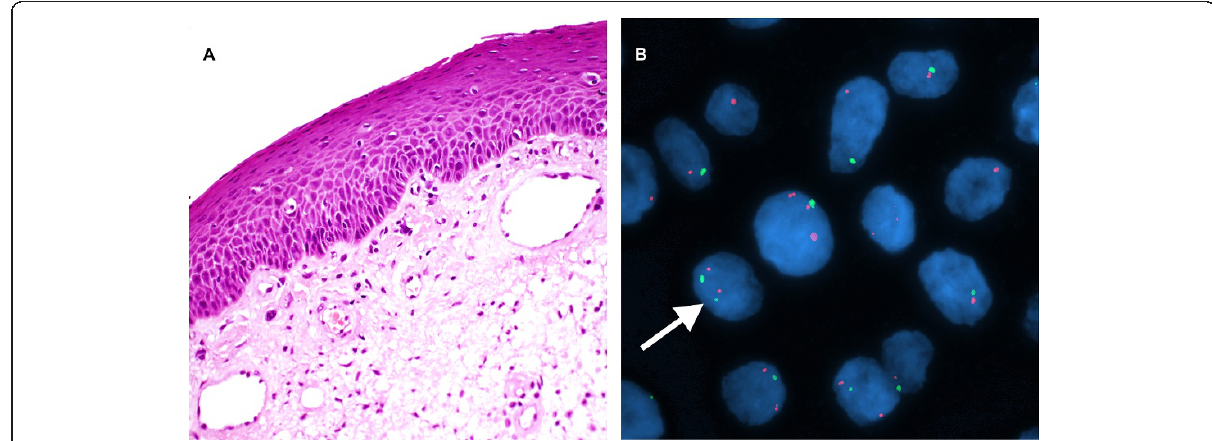
Figure 1 A case of normal epithelium of the larynx . A. H&E stain. (magnification, ×200). B. Interphase FISH displaying a normal signal pattern containing two copies (arrow) each of hTERC (red) and chromosome 3 centromere specific probe CSP3 (the internal control probe) (green), the CSP3: hTERC signal pattern is 2:2 (green:red). ( ×